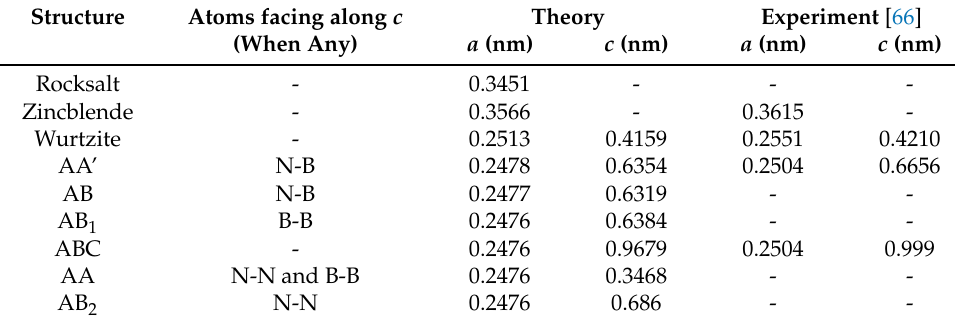
Table 1. Theoretical and experimental values of the lattice parameters for nine Bravais lattices of boron